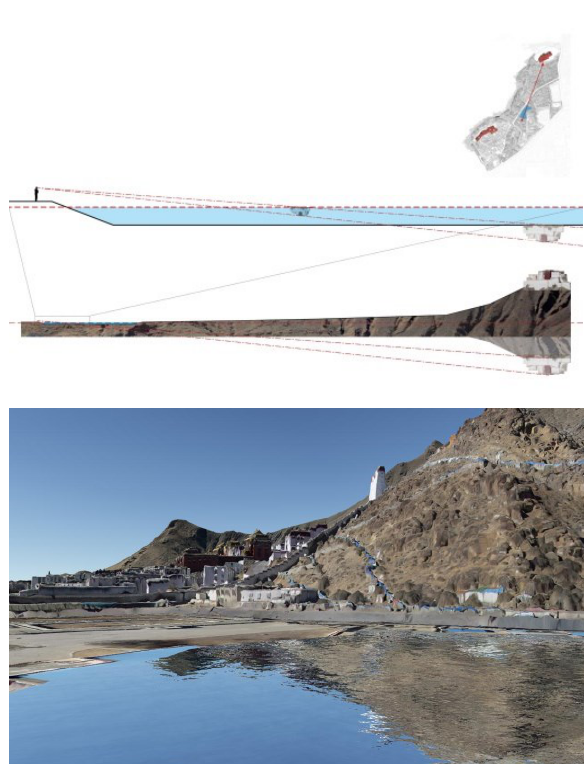
Figure 12. 3D oblique photography of current conditions overlay with simulated water body planned (2) The source of water is the melted snow and ice on the